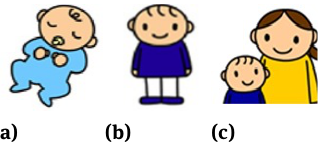
Fig. 6. Three different figures representing a baby (a), a friend (b), and a mother (c)